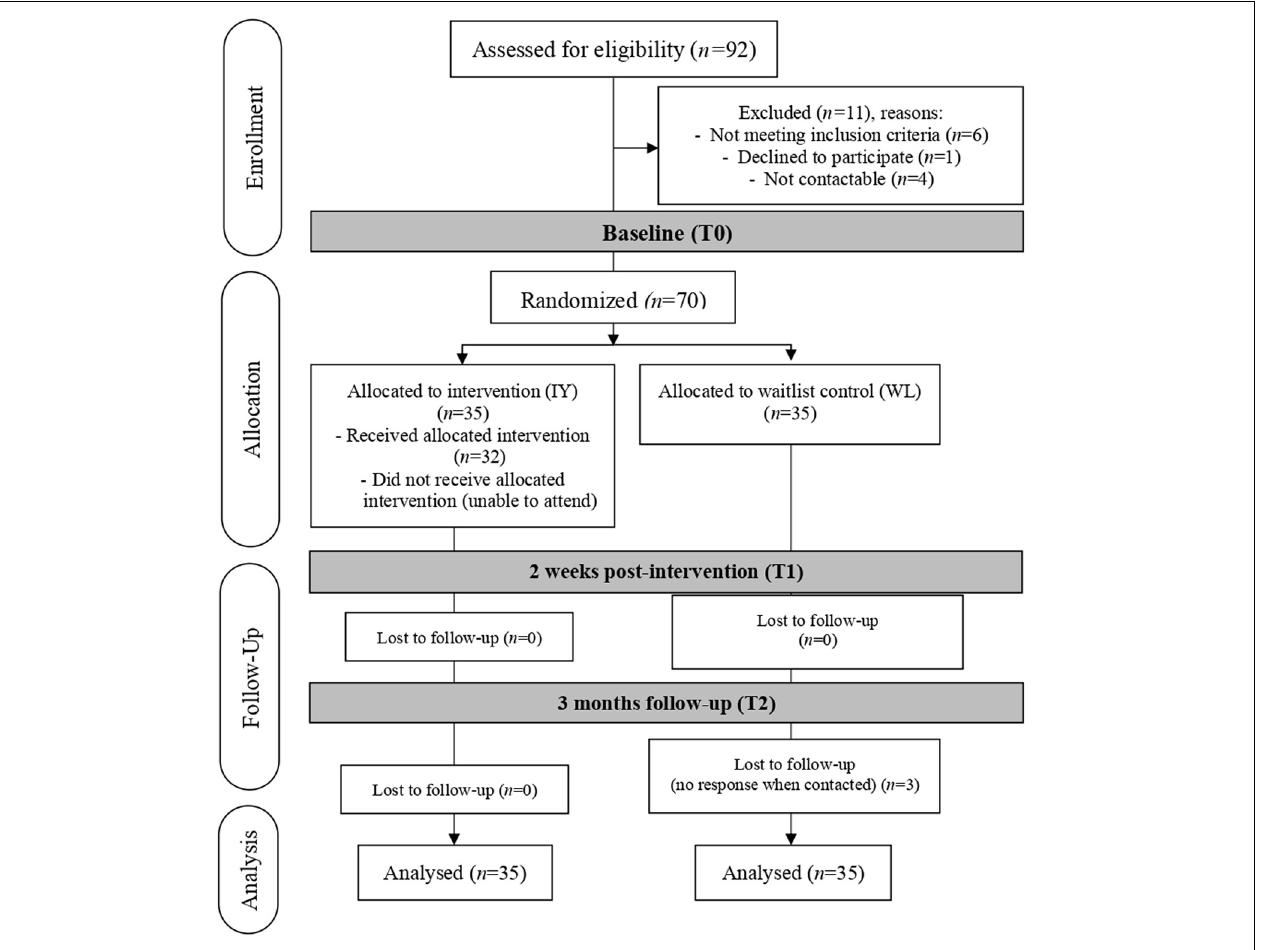
FIGURE 1 | The flow of study. Adapted from “CONSORT 2010 statement: Updated guidelines for reporting parallel group randomized trials”, by Schulz et al., 2010. CC BY